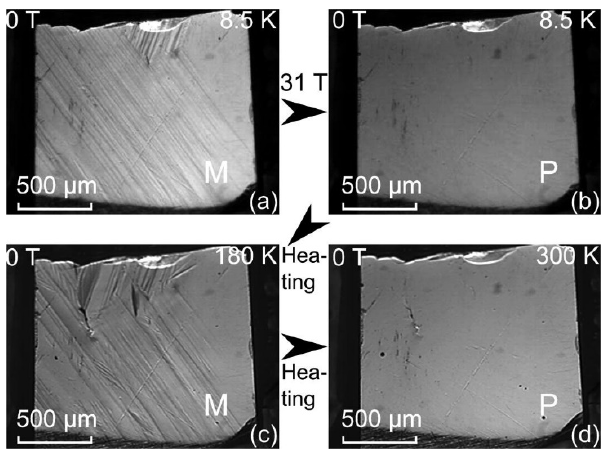
Figure 17. Micrographs: ( a ) before and ( b ) after a 31 T pulsed magnetic field application at 8.5 K. Parent phase (P—austenite) was arrested even when the magnetic field became zero in ( b ); ( c ) martensite phase obtained at 180 K out of an abnormal heating ‐ induced transformation; ( d ) the martensite phase eventually transferred back to parent phase when further heated to 300 K [131], with copyright permission from © Pergamon .